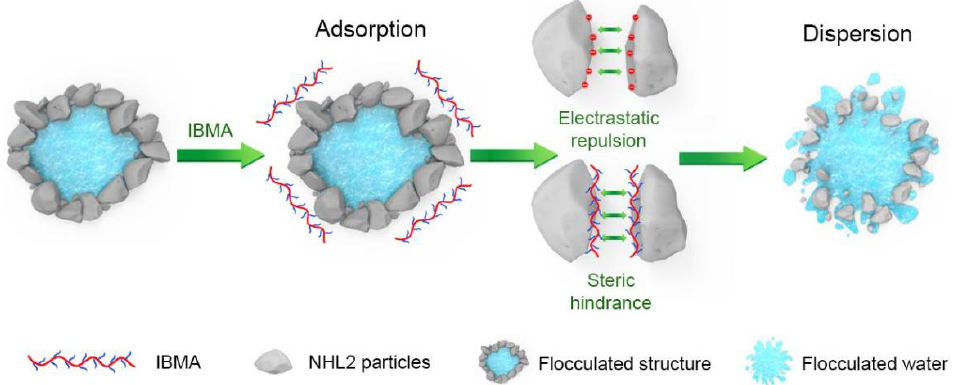
Figure 9. Schematic illustration of the effect that IBMA has on the microstructure of an NHL paste.